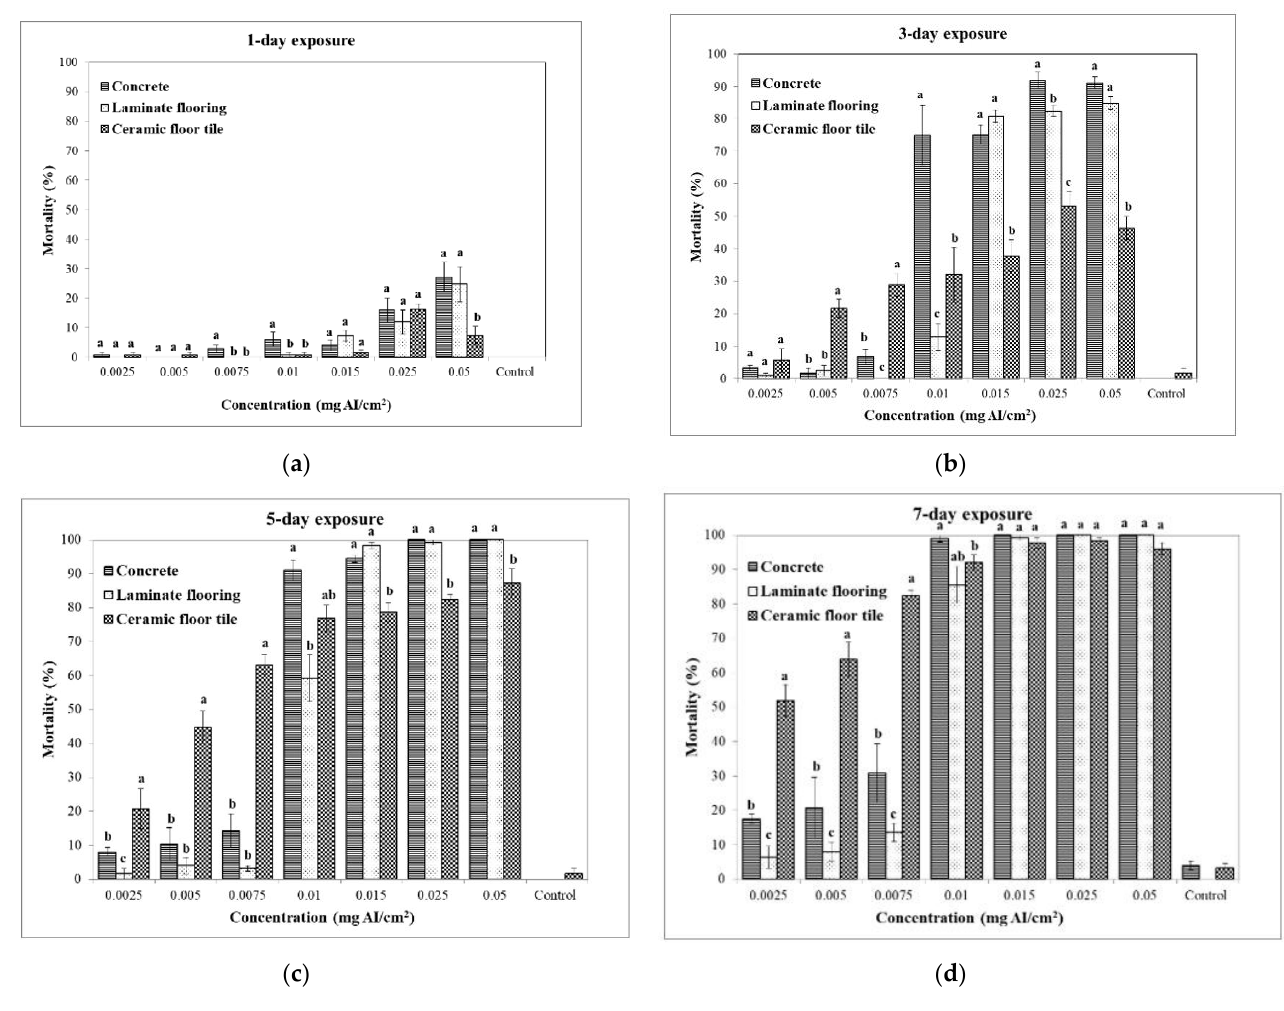
Figure 1. Mean corrected mortality (% ± SE) of Acanthoscelides obtectus adults after ( a ) 1-, ( b ) 3-, ( c ) 5- and ( d ) 7-day exposure to concrete and laminate flooring and ceramic floor tile surfaces treated with spinetoram at eight different concentrations. Means within each diagram and concentration are followed by the same lower-case letter are not differ significantly different (Tukey’s HSD test at 5% level).